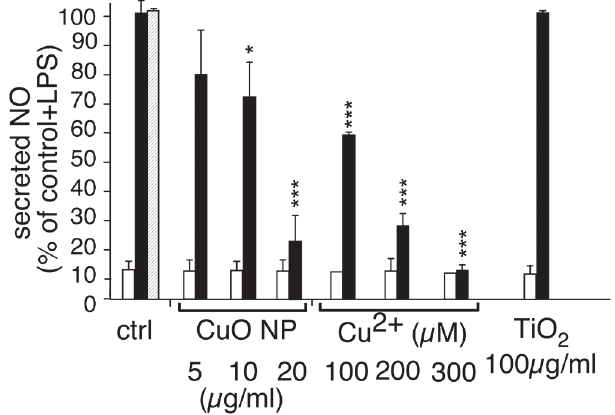
Fig 7. Alteration of NO production. The NO production was evaluated after treatment with particles or copper ion. Black bars, after further stimulation with 1 μ g/ml of lipopolysaccharide (LPS). White bars, without stimulation with LPS. Hatched bar: stimulation with PVP (4 μ g/ml) and LPS. The results are expressed in percentage of the activity of control cells after LPS stimulation. Both measurements were carried out in triplicate on independent cultures and the statistical confidence in the Student T-test is indicated as follows: * : p (cid:1) 0.05; ** p (cid:1) 0.01; *** p (cid:1) 0.001.